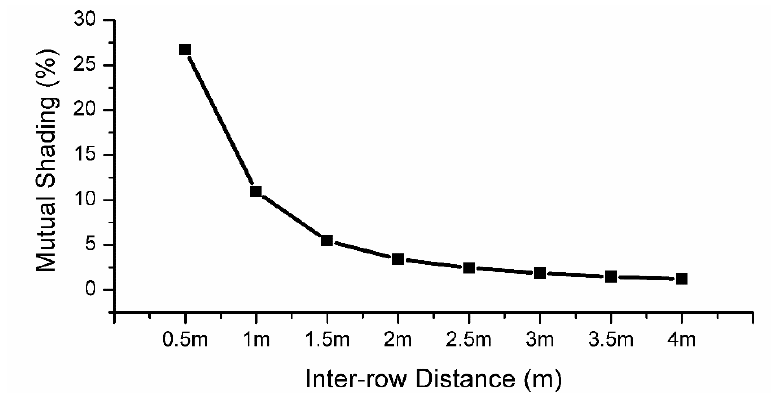
Figure 6. Diffuse shading at various interrow distances.